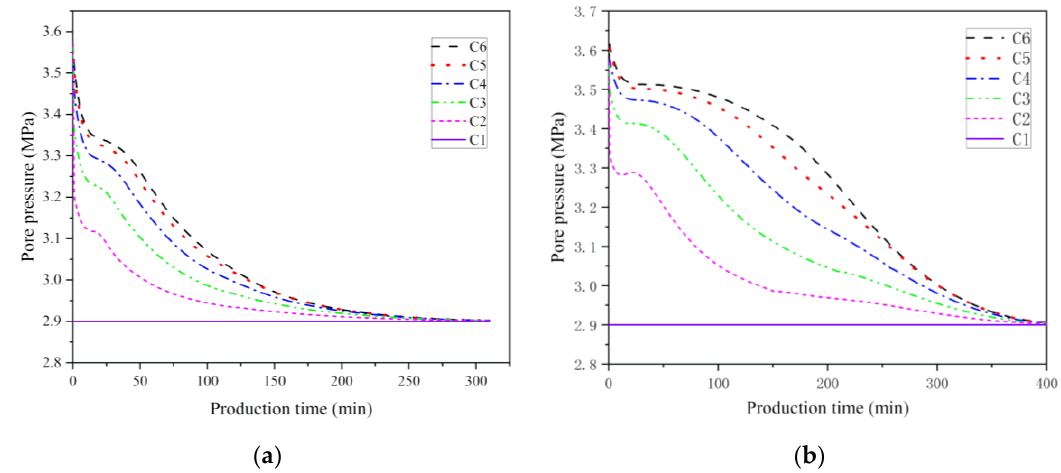
Figure 6. Pore pressure variation with production time for the mechanical ( a ) uncoupled and ( b ) coupled model.